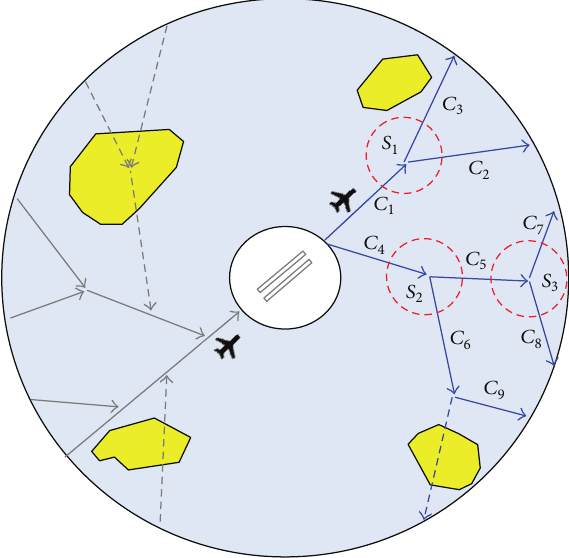
Figure 1: Terminal-area aircraft intent inference